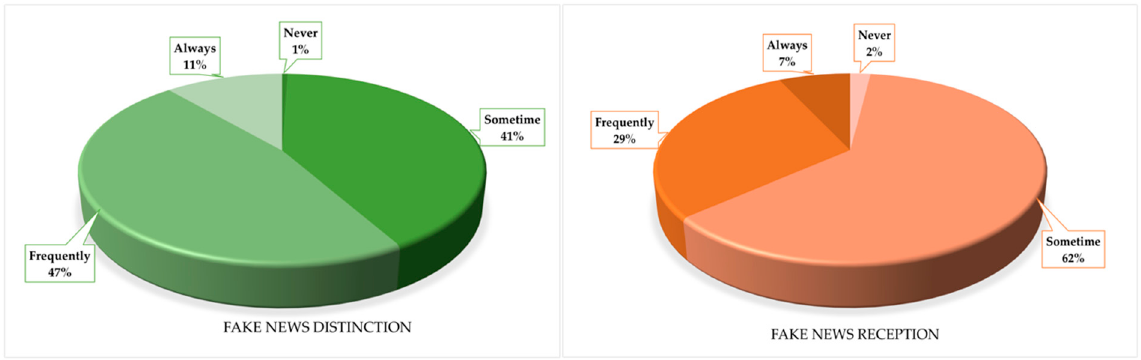
Figure 6. Fake news distinction and reception. Own elaboration.